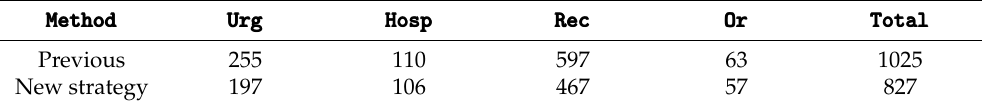
Table 7. Number of critical events for both prioritization methods obtained from the information